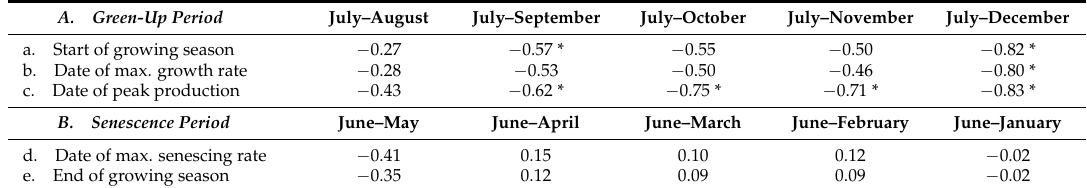
Table 4. Pearson’s correlations ( r ) between mean rainfall of five meteorological stations in the study area (Rustenburg, Marbel Hall Moosriver, Lephalale, Bloemhof and Escelsior-benchmark) and green-up or senescence period phenological metrics for 100 randomly selected plots in the study area.